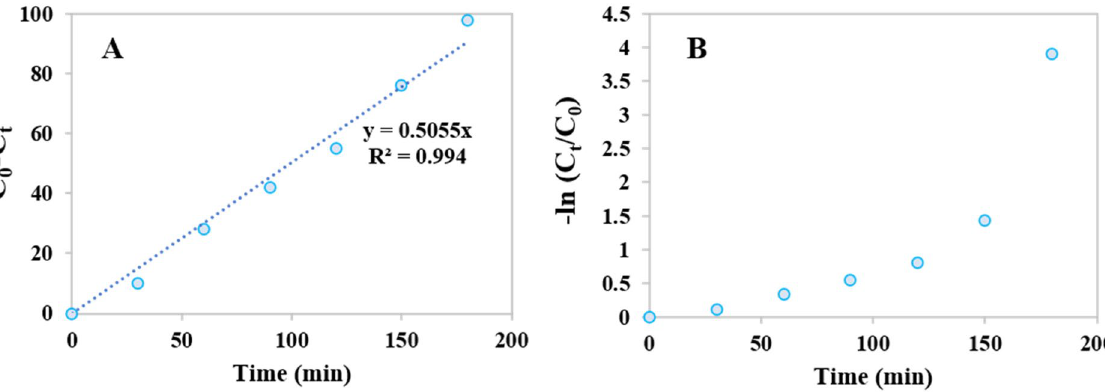
Figure 8. Zero-order ( A ) and pseudo-first-order ( B ) degradation kinetics of 4-NP on (N,